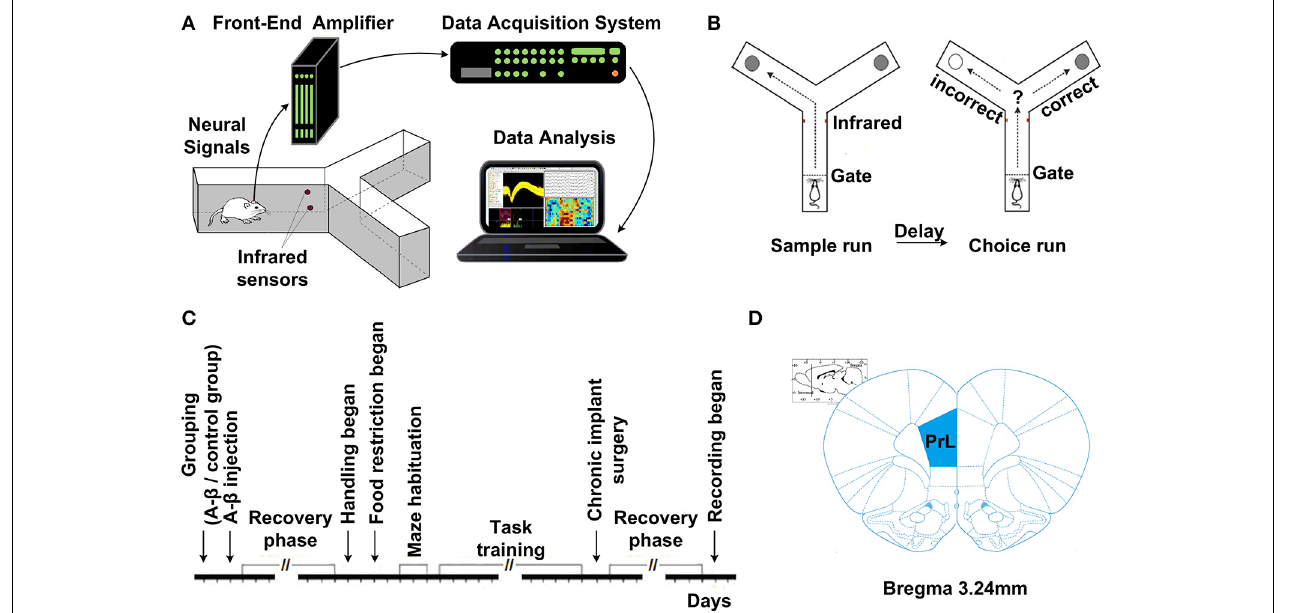
FIGURE 1 | Experiment setup and procedures. (A) Diagram of experimental setup, consisting of a rat with implanted microelectrodes in a Y-maze, the Cerebus front-end amplifier, the Cerebus data acquisition system and analysis software. (B) Schematic representation of the delayed-alternation task in Y-maze. Dashed lines represent the locations of removable guillotine doors that restricted access to different parts of the maze. Food cups, which are used for reward delivery, are located at the ends of two arms. Arrows show possible correct paths. Each trial consisted of a